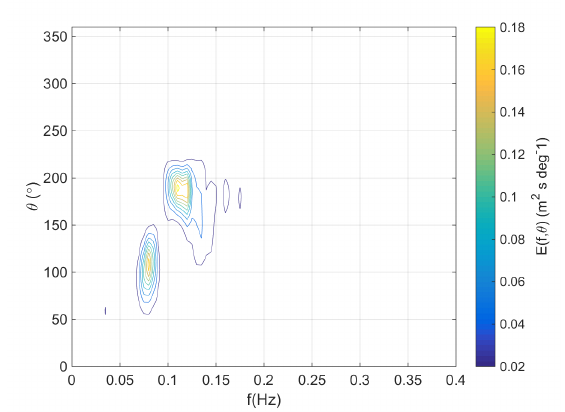
Figure 3. Directional wave spectrum for example given in Figure 4. Directional wave spectrum is estimated using a directional TRIAXYS wave rider buoy.